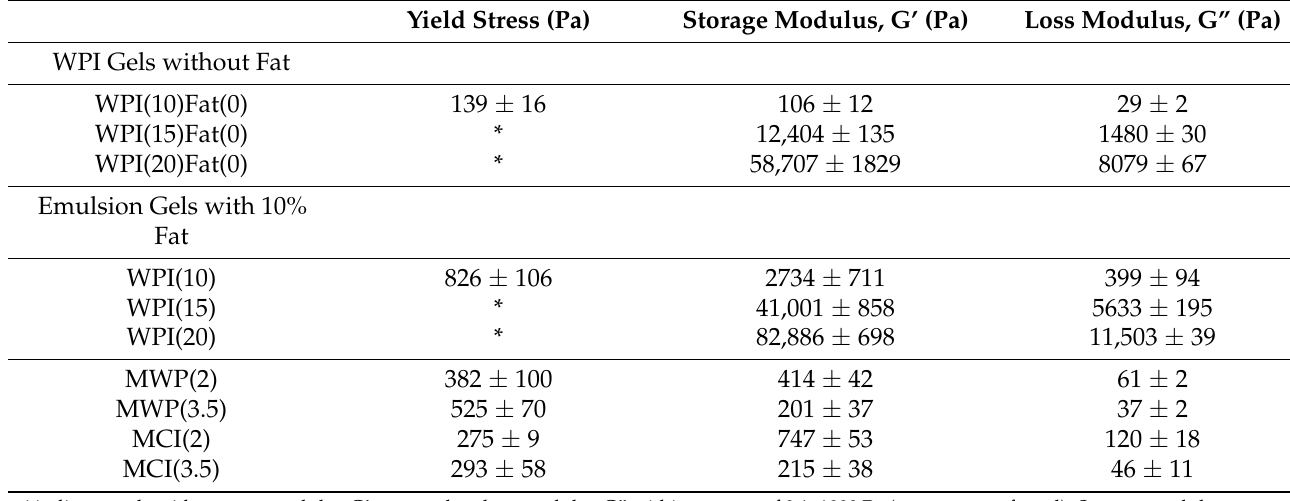
* indicates gels with storage modulus G’ greater than loss modulus G” within stresses of 0.1–1000 Pa (no crossover found). Storage modulus G’ and loss modulus G” obtained in the linear viscoelastic region (0.1–1 Pa). Given are averages of triplicate measurements ± std.